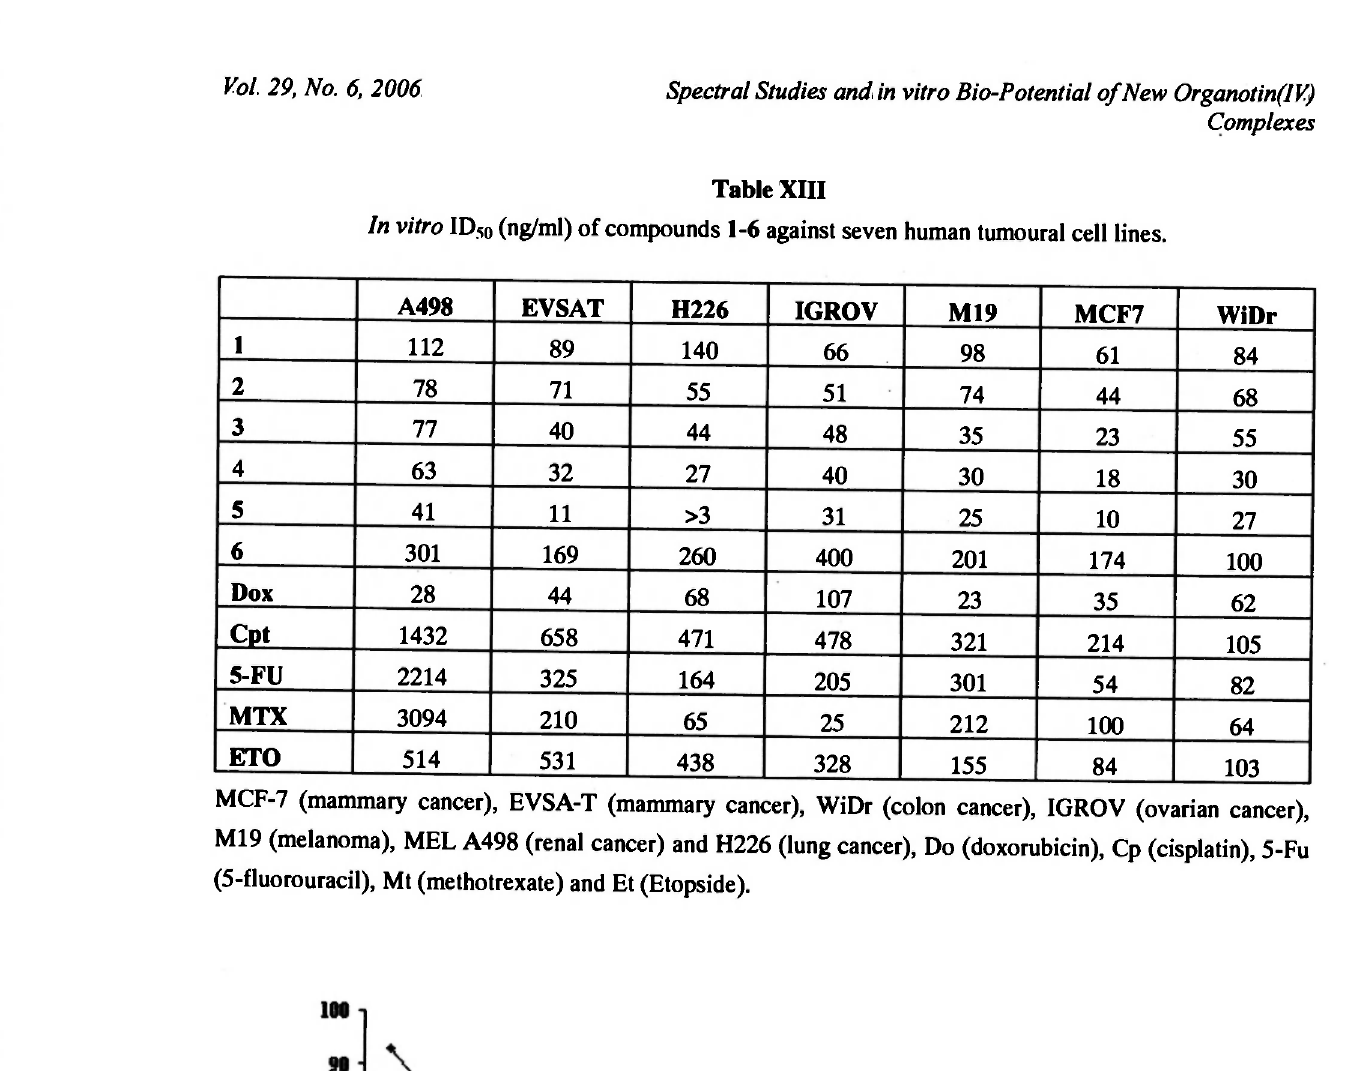
In vitro ID 50 (ng/ml) of compounds 1-6 against seven human tumoural cell lines.